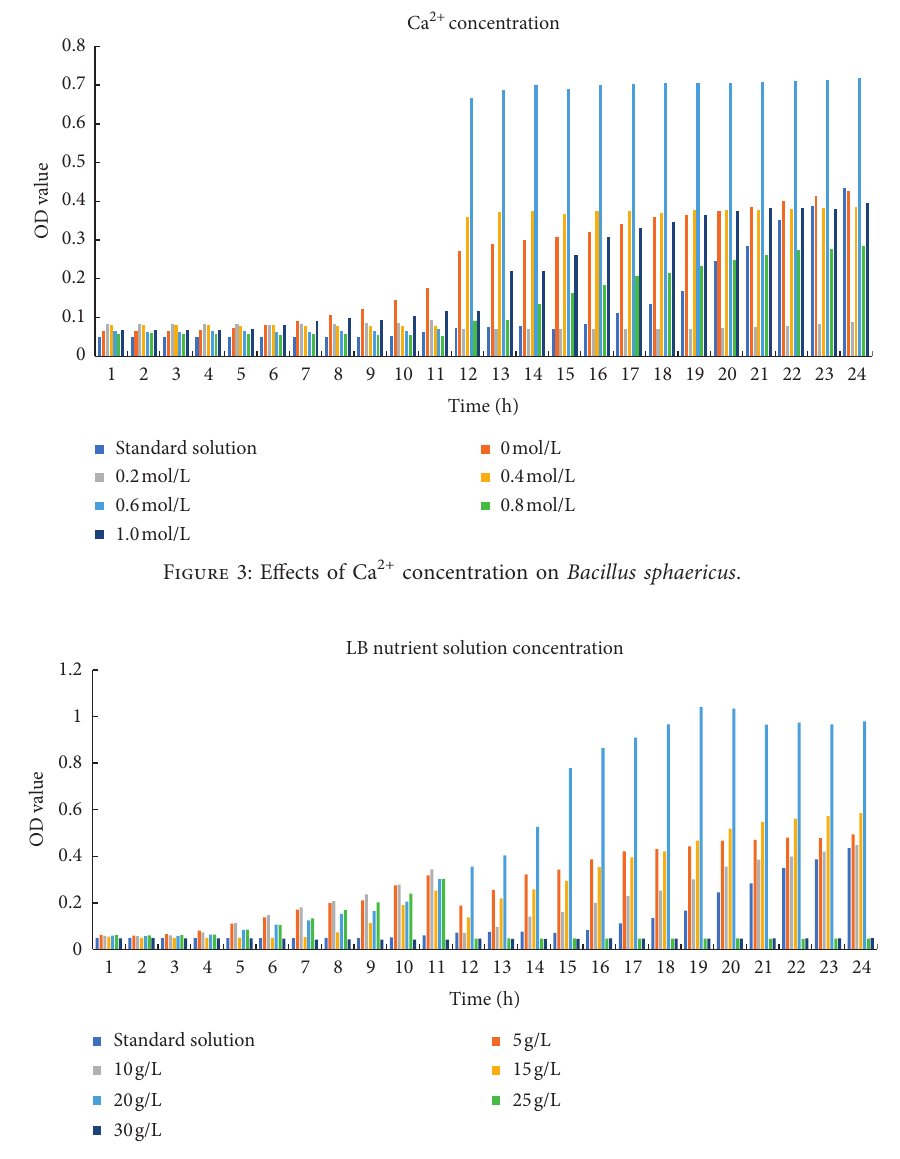
Figure 4: Effects of LB nutrient solution concentration on Bacillus sphaericus